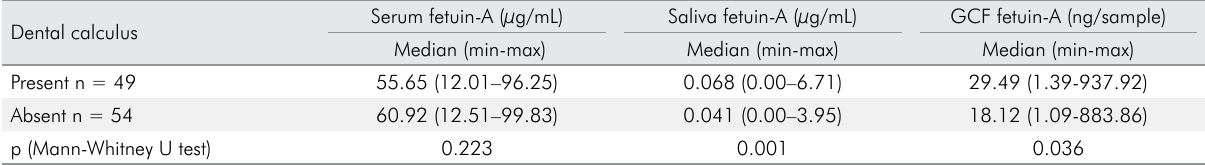
Table 2. Median, minimum and maximum levels of fetuin-A in serum, saliva and gingival crevicular fluid (GCF) according to dental calculus situation (presence or